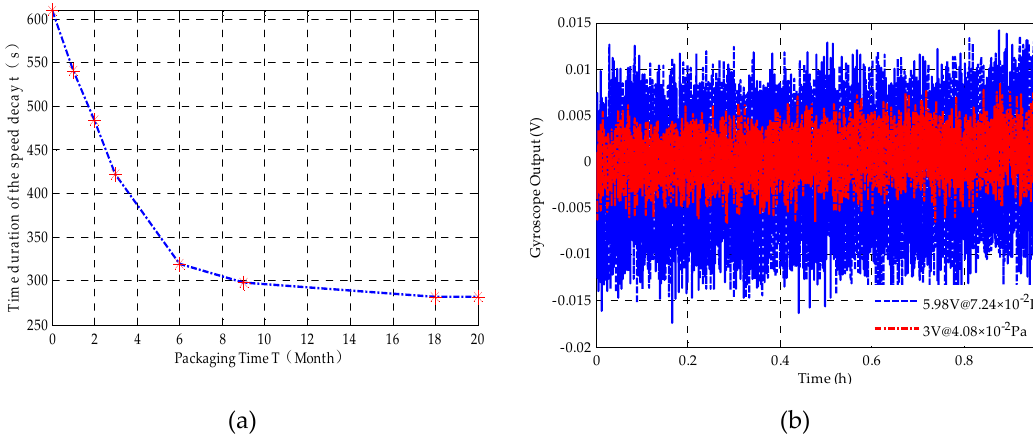
Figure 3. ( a ) Stability of vacuum tests up to 20 months and ( b ) gyroscope noise at different drive voltages.